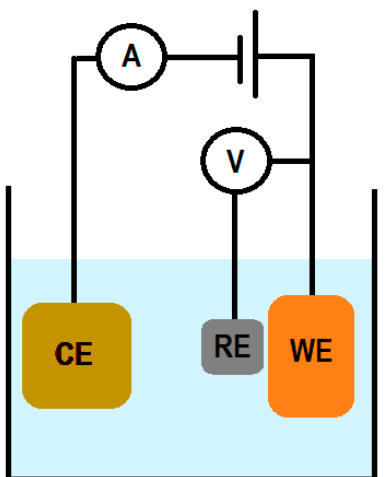
Figure 1. A three-electrode system consists of a working electrode (WE) where the reaction of interest occurs, a counter electrode (CE) to pass the needed current to WE and a reference electrode (RE) which the WE potential is measured against. A: Ammeter. V: Voltmeter.